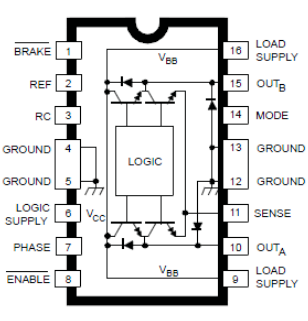
Figure 10: Schematic of the A3953 Full‐Bridge PWM Motor Driver [11] Figure 13. Schematic of the A3953 Full-Bridge PWM Motor Driver [8]. For this application, the pulse‐width modulated signal will be input at the PHASE pin (pin 7). OUT A will be connected to the motor’s negative terminal, and OUT B will be connected to the motor’s positive of how far and in which direction the motor has turned. This is accom- terminal. The motor terminals are indicated in Figure 8 by blue squares. The LOAD SUPPLY pins should plished with the LS7366R Quadrature Counter with Serial Peripheral be connected to +12V. The BRAKE pin will be pulled up to 3.3V to disable that function. Interface (SPI). A schematic of this chip is shown in figure 14 [9]. The previously mentioned SPI protocol is fully compatible with the F28335 [8]. The quadrature encoder channels A and B are connected to the A and B pins, respectively (pins 12 and 11). The SPI bus is serviced on the SS , SCK , MISO , and MOSI pins (pins 4, 5, 6, and 7). Figure 11 [10]. The previously mentioned SPI protocol is fully compatible with the F28335 [13].